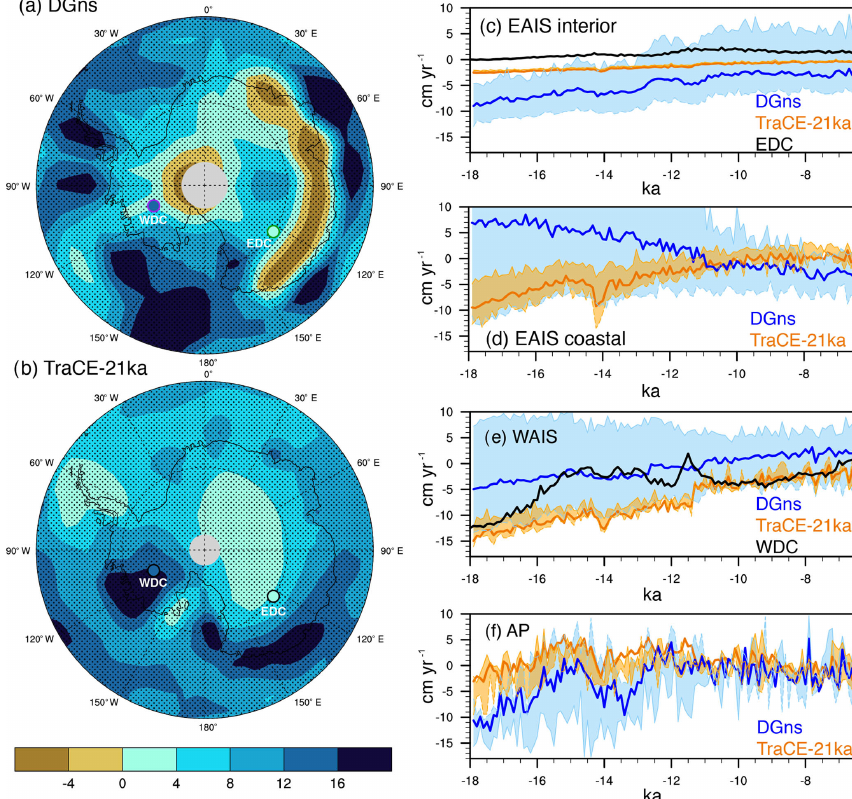
Figure 3. Precipitation change (cmyr − ) as simulated in (a) DG ns and (b) TraCE-21ka for the period of 18 to 6.5ka (maximum latitude of 60 ◦ S). Dotted lines indicate latitude (intervals of 15 ◦ ) and longitude (intervals of 30 ◦ ). Ice core locations of WDC and EDC are marked by filled circles, with the fill colour corresponding to the change estimated in the ice core record, black outlines indicating a match in warming between the ice core and model simulation (i.e. the ice core temperature change from 18 to 6.5ka is within the range of seasonal temperature changes of the climate model), and green (purple) outlines indicating an overestimation (underestimation) in warming by the models. For these model–proxy comparisons, we use site-specific model averages of land surface grid cells: WDC (77–82 ◦ S, 115–109 ◦ W), EDC (73–77 ◦ S, 121–127 ◦ E). Stippling indicates a difference between decadal output of 18.0–17.5 and 7.0–6.5ka that is significant at the 95% confidence level. (c–f) 100-year average accumulation time series (cmyr − ) of four regions (EAIS interior: 83–75 ◦ S, 30 ◦ W–165 ◦ E; coastal EAIS: 75–68 ◦ S, 15 ◦ W–165 ◦ E; WAIS: 83–72 ◦ S, 165 ◦ E–30 ◦ W; AP: 72–64 ◦ S, 64–59 ◦ W) relative to PI of both model simulations ( P – E ) and ice core accumulation reconstructions of sites located therein (DG ns in blue, TraCE-21ka in orange, ice cores in black). The coloured shading indicates the seasonal range calculated from the 100-year average austral summer and winter temperature